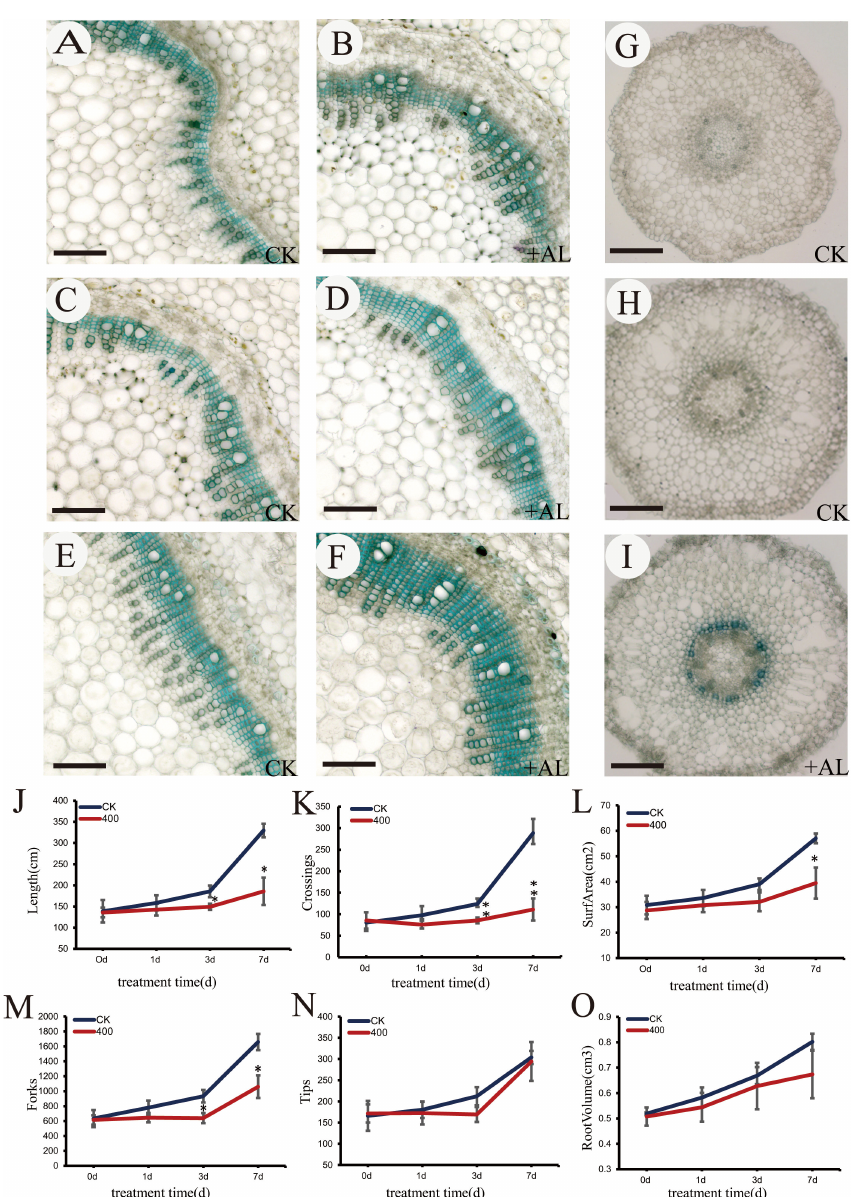
Figure 2. Aluminum stress inhibits the growth of stems and roots. ( A , B ) Stem section of control group and treatment group at 1 day. ( C , D ) Stem section of control group and treatment group at 3 days. ( E , F ) Stem section of control group and treatment group at 7 days. ( G ) Root tip section of control group at 1 day. ( H ) Root tip section of control group at 7 days. ( I ) Root tip section of treatment group at 7 days. The scale bar is 200 µ m. ( J ) Total root length. ( K ) Cross number. ( L ) Surface area. ( M ) Branch root number. ( N ) Root tip number. ( O ) Total root volume. The error line represents the average ± SD of the three organisms. The * above the column chart indicated that the growth change between the two samples was significant (Students’ t -test,* p < 0.05, ** p <